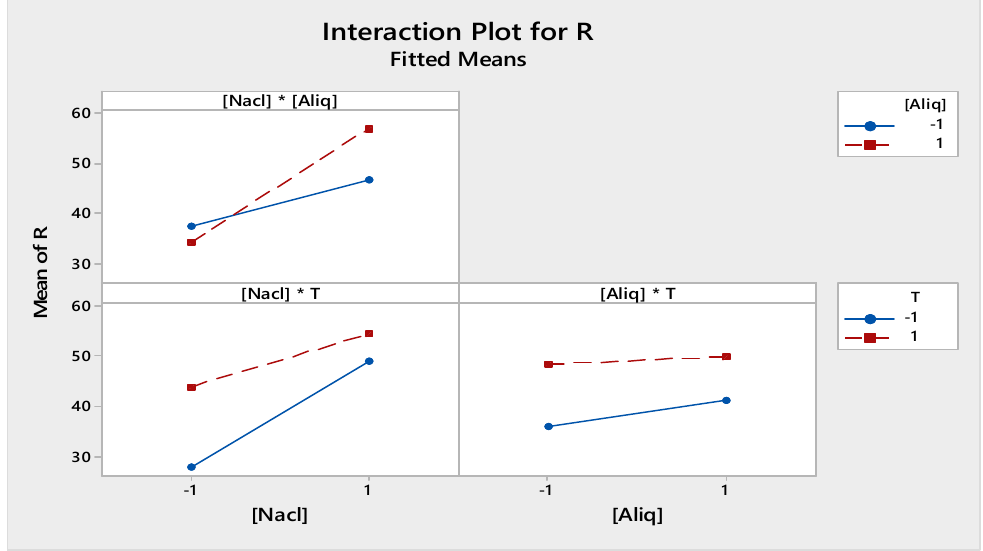
Figure 11. Factors of interactions effects plots for receiving phase.